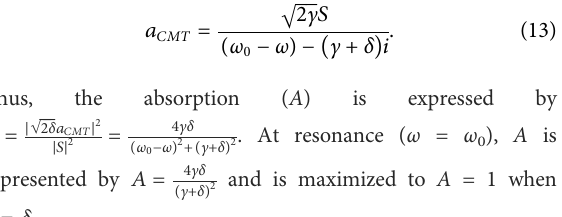
Figure 5H (reproduced from Ref. [47]). The resonator in a waveguide